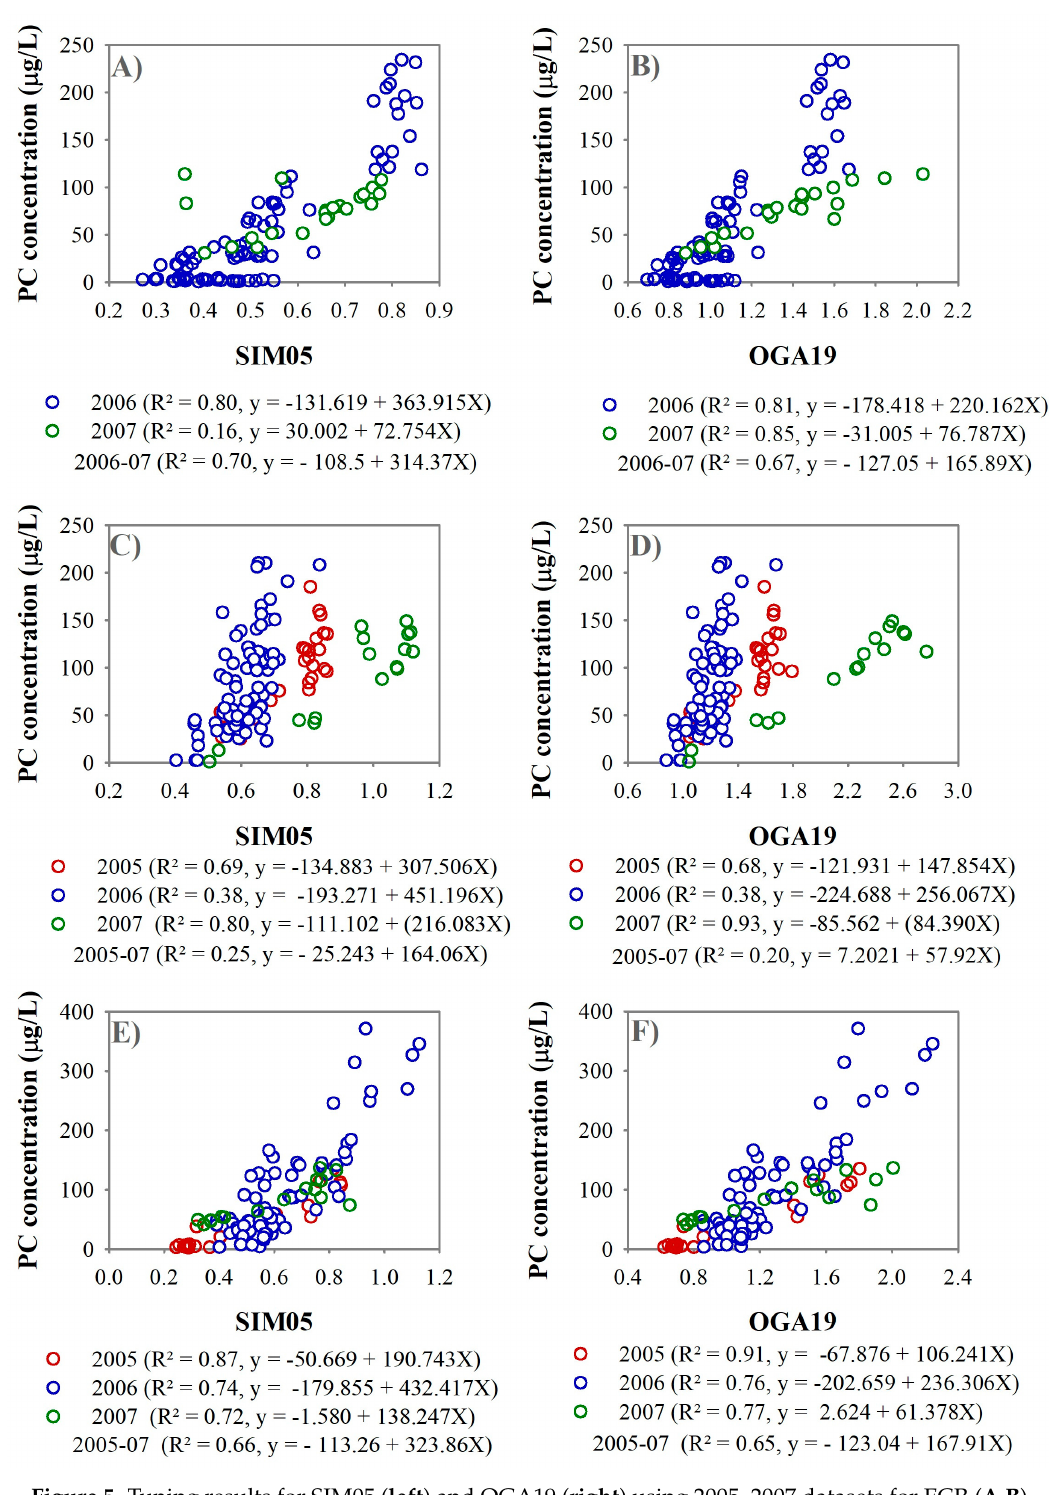
Figure 5. Tuning results for SIM05 ( left ) and OGA19 ( right ) using 2005–2007 datasets for ECR ( A , B ), GR ( C , D ) and MR ( E , F ).